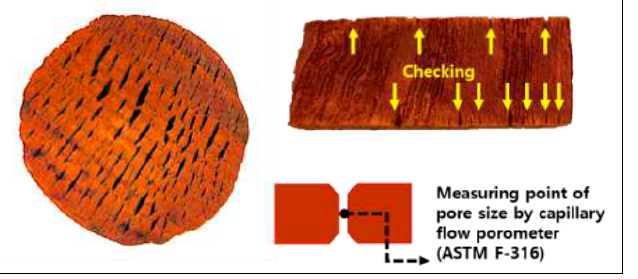
Figure 5. Checking of delignification-treated red toon and measuring point of pore size by capillary flow porometer.